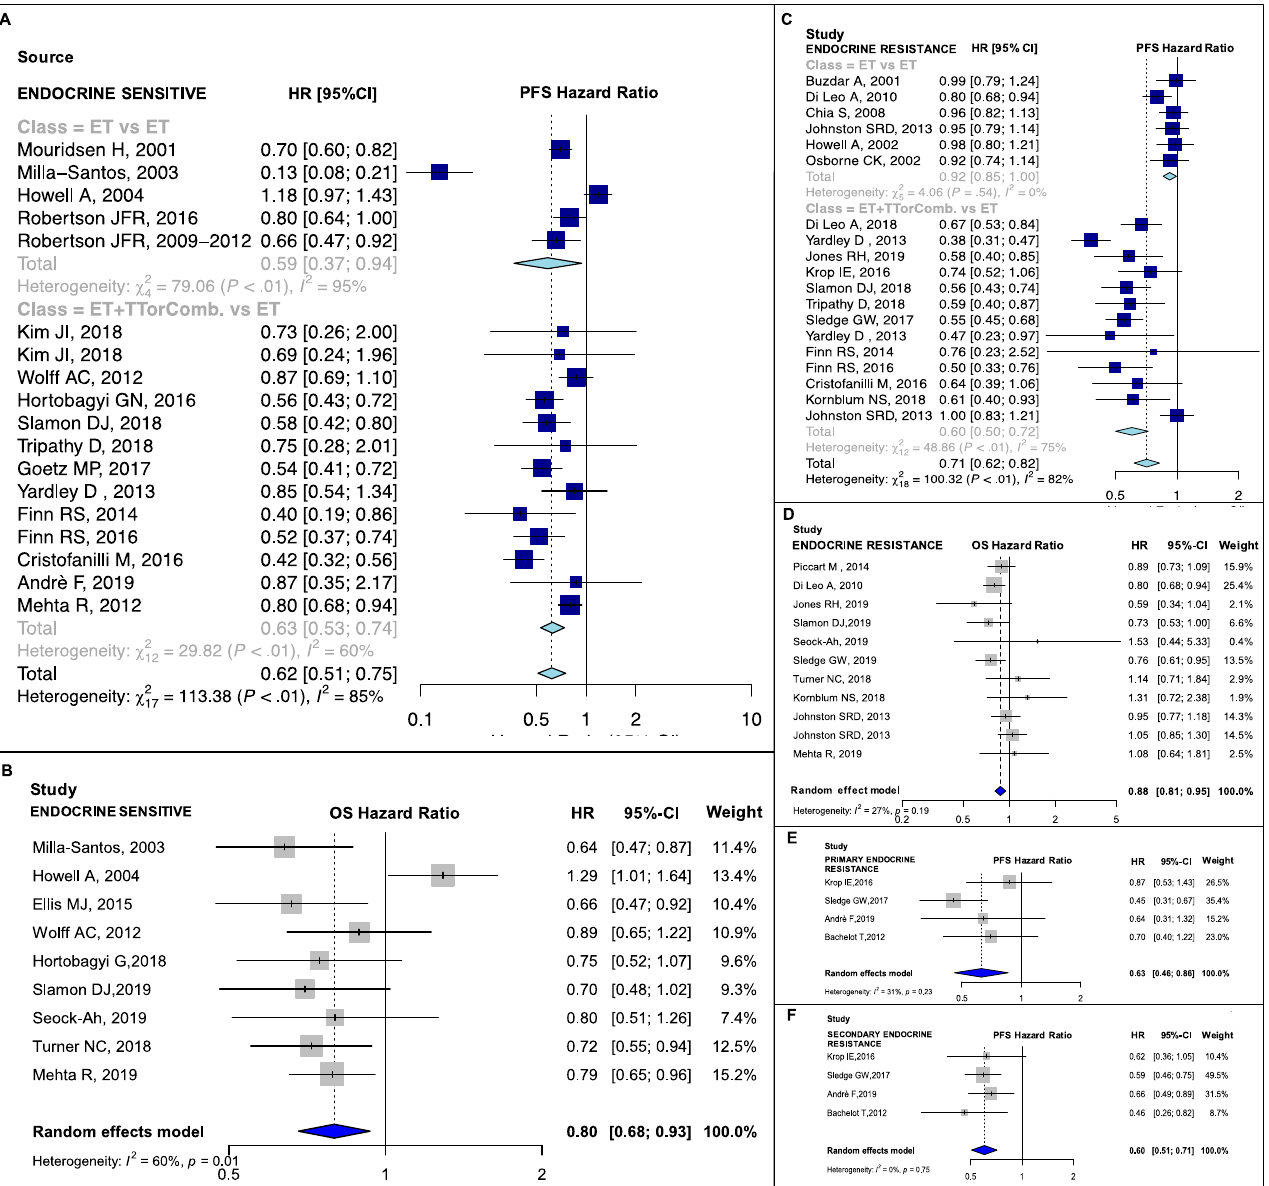
Figure 4. PFS and OS pooled results according to endocrine sensitiveness: PFS pooled result for the endocrine sensitive ( A ) and resistant ( C ) subgroups; OS pooled result for the endocrine sensitive ( B ) and endocrine resistant ( D ) subgroups; and PFS pooled result for the primary endocrine resistant ( E ) and secondary endocrine resistant ( F ) subgroups; PFS, progression-free survival; OS, overall survival; ET vs. ET, studies comparing single agents endocrine therapies; ET+TT or Comb. vs. ET, studies comparing endocrine therapies + target therapies or endocrine therapies combinations against single agent endocrine treatments; HR, hazard ratio; 95% CI, 95% confidence interval.